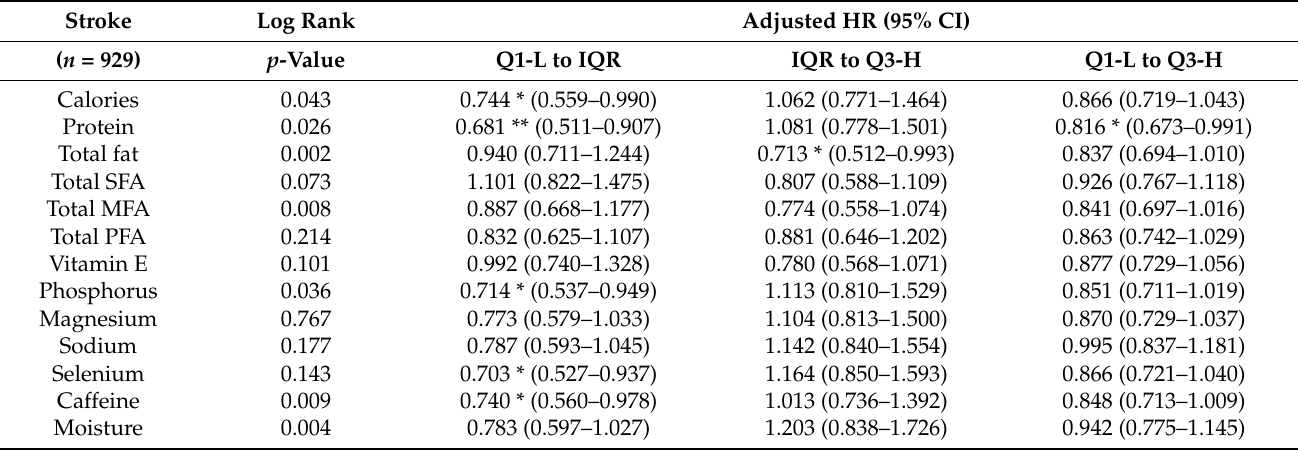
Table 4. Impact of dietary consumption on survival of stroke patients.